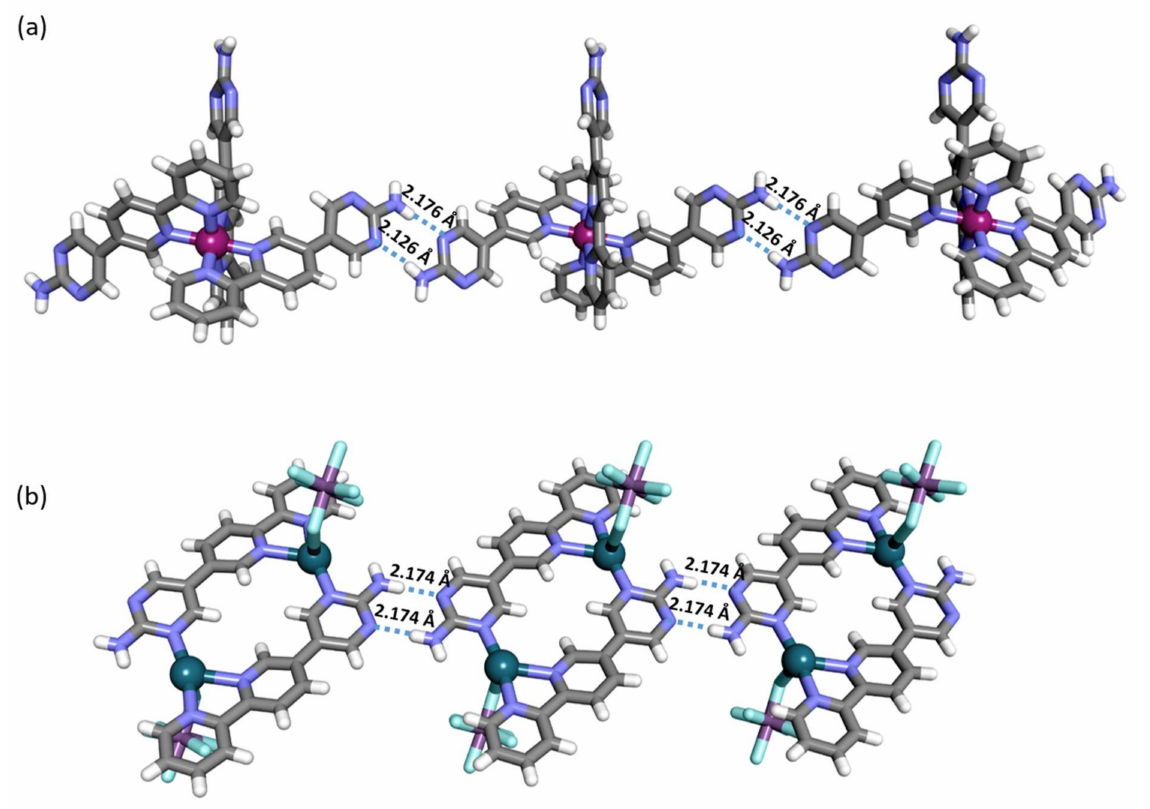
Figure 2. ( a ) Portion of the polymer formed by the [Fe II L 3 ](BF 4 ) 2 · 9H 2 O, ( b ) portion of the polymer formed by the [Ag 2 L 2 ](SbF 6 ) 2